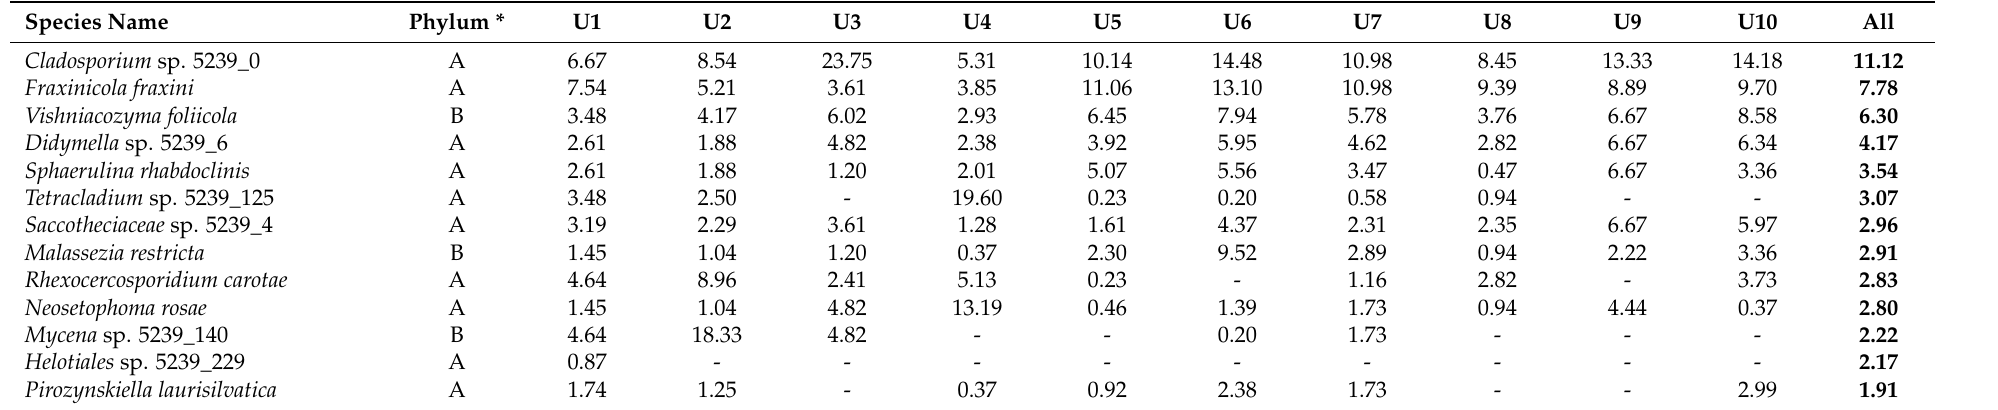
Table 6. Occurrence and relative abundance (%) of the 40 most common fungal taxa (shown as a proportion of all high-quality fungal sequences) in root samples from ten populations of Fraxinus excelsior in